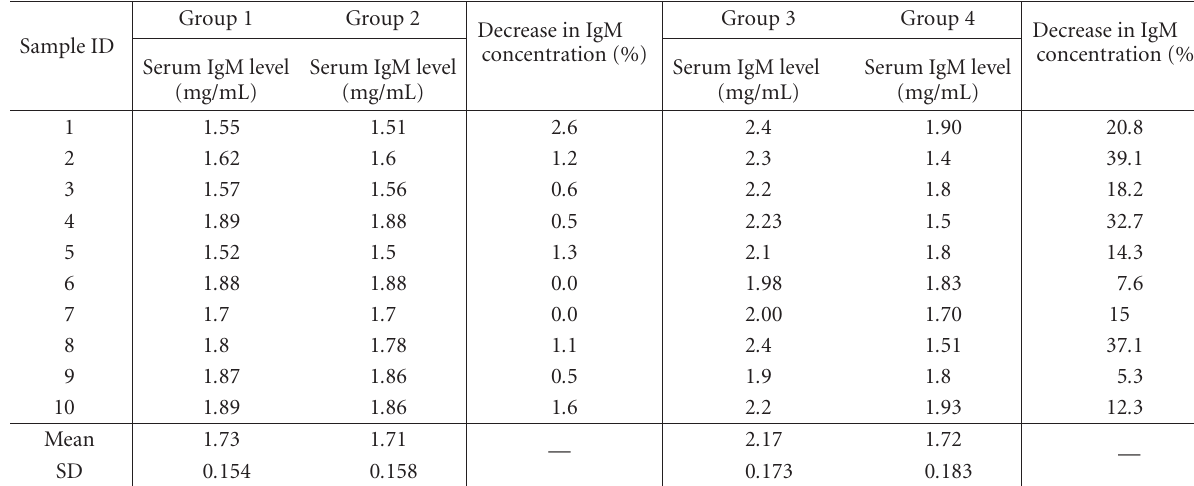
Table 2. E ff ect of anti-BSA IgM antibodies on turbidimetric